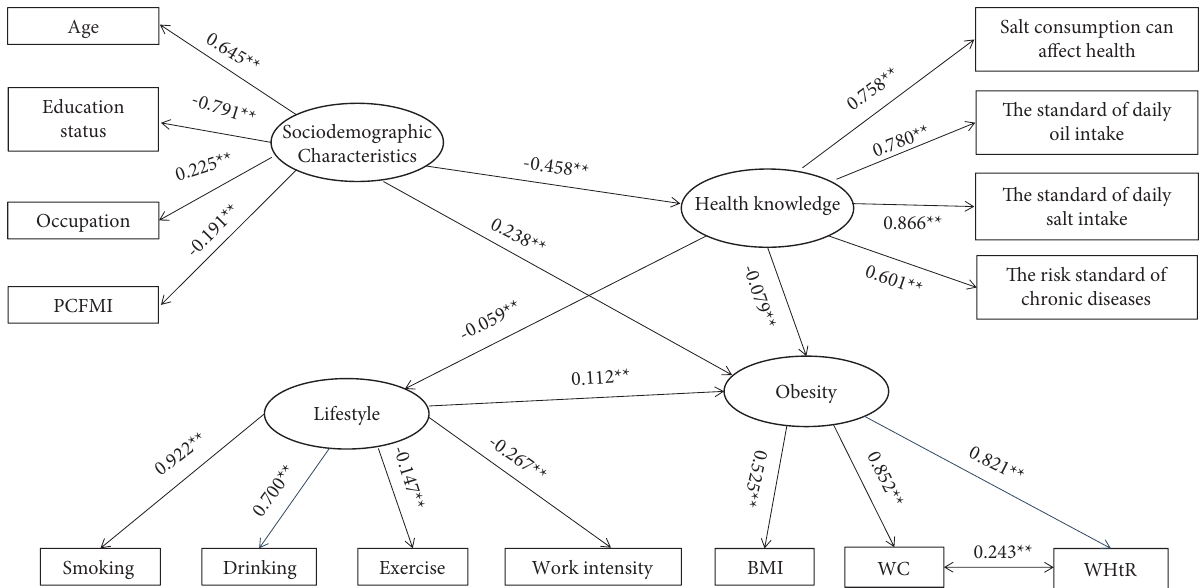
Figure 2: The measurement model of latent variables. Four latent variables and 15 manifest variables are connected by significant paths. Note . ∗∗ P < 0 . 001 (two-tailed test). All path coefficients shown were standardized. PCFMI: per capita family monthly income; BMI: body mass index; WC: waist circumference; and WHR: waist-to-height ratio.